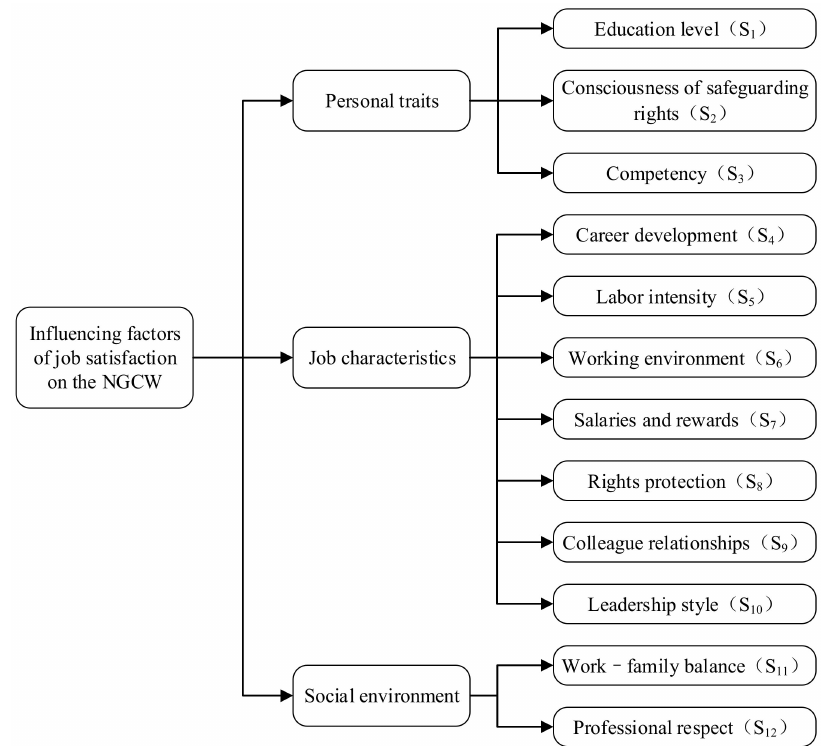
Figure 1. Index system of influencing factors of job satisfaction of the